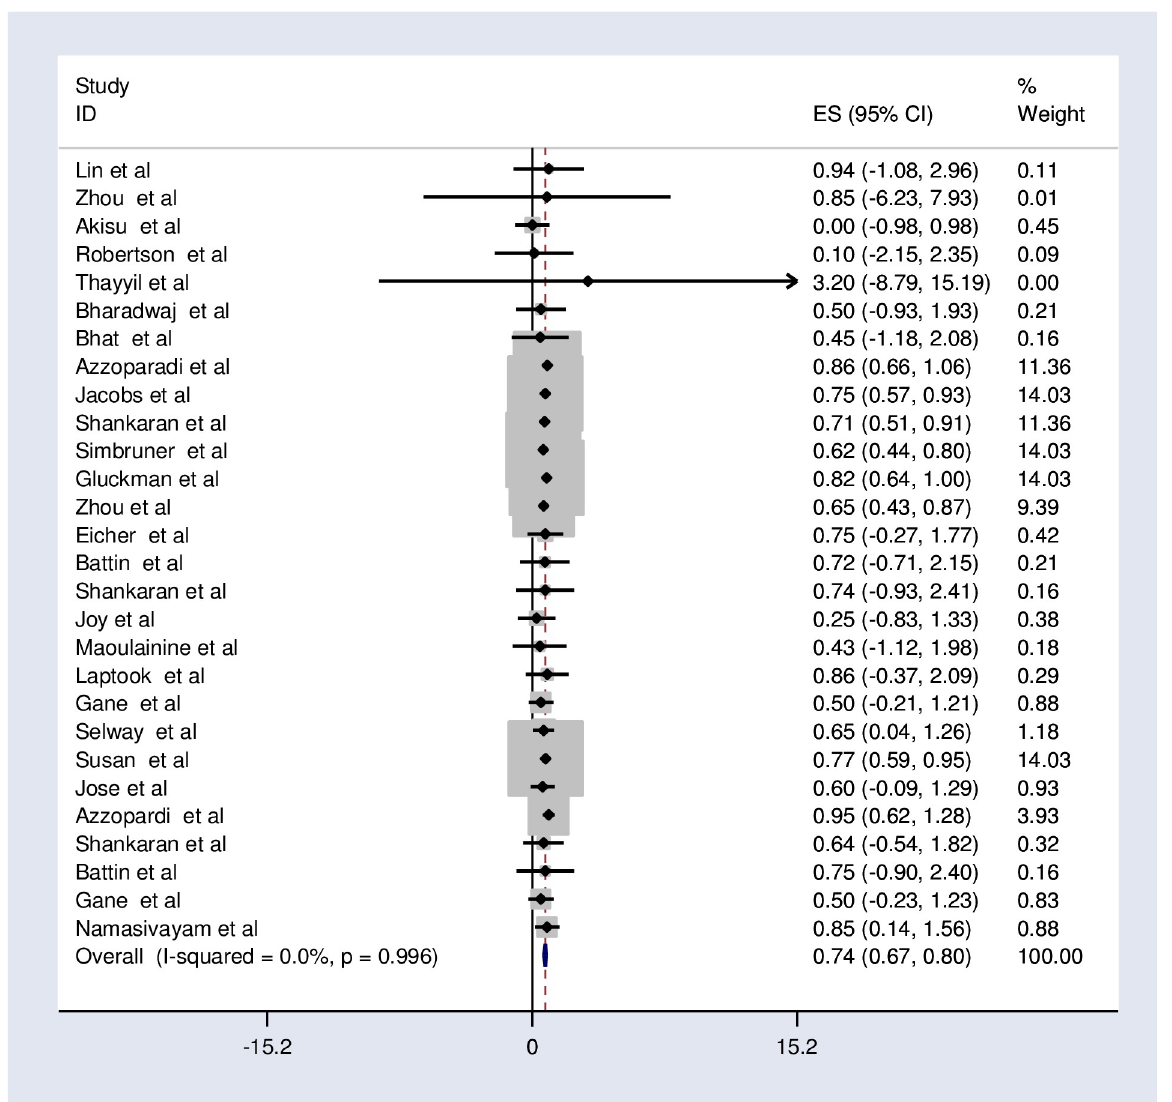
Fig 2. Forest plot showing the effects of therapeutic hypothermia on death among asphyxiated neonates with hypoxic-ischemic encephalopathy.